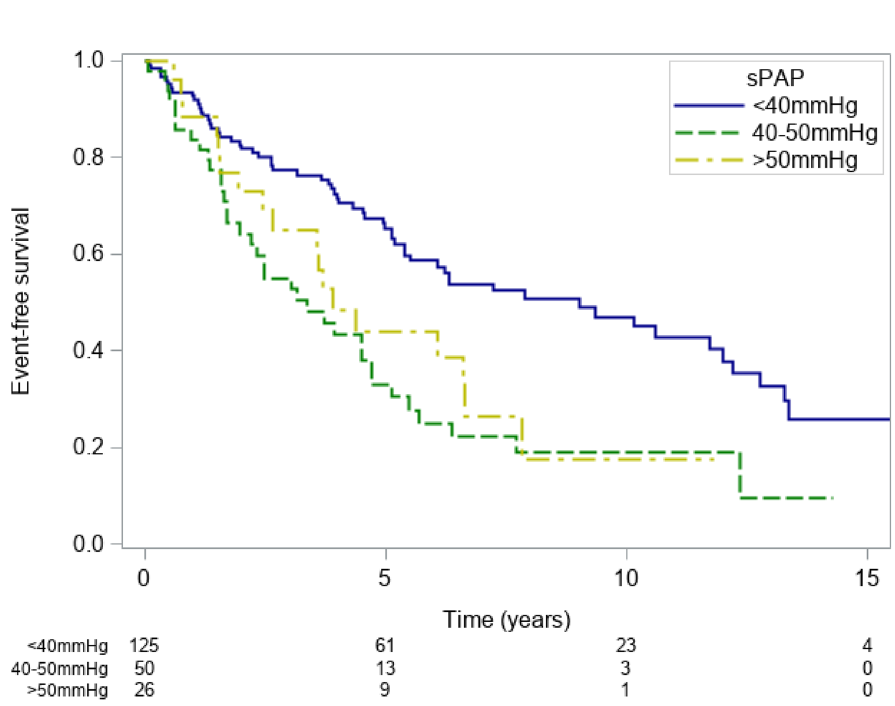
Figure 3. Kaplan–Meier event-free survival estimates for patients with sPAP < 40 mmHg (blue line), 40–50 mmHg (green line) and > 50 mmHg (yellow line). sPAP systolic pulmonary artery